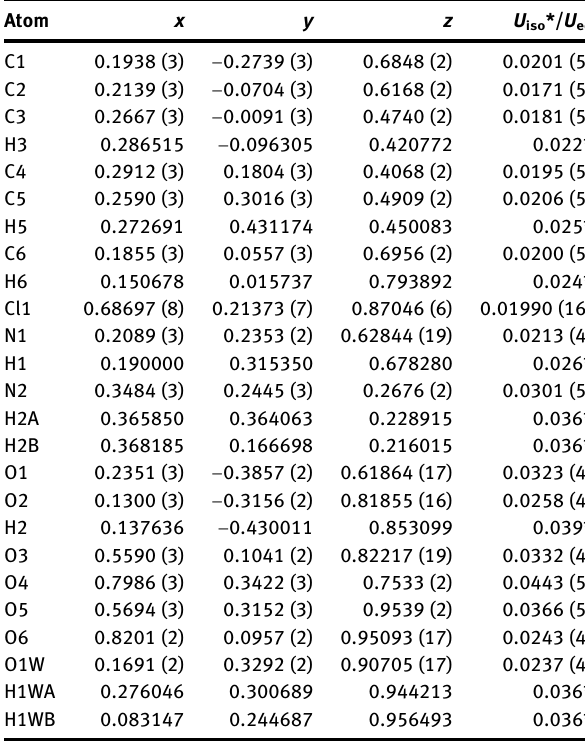
Table  : Fractional atomic coordinates and isotropic or equivalent isotropic displacement parameters (Å 